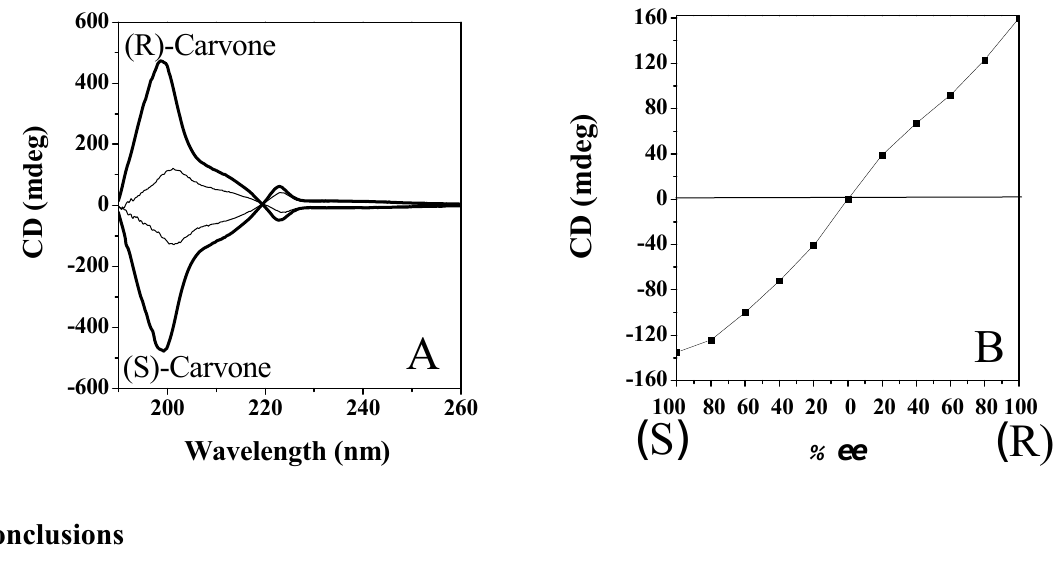
Figure 25. (a) CD spectra of s-PS films, obtained by spin-coating, after exposure to vapor of R or S-carvone. The spin-coating process has been conducted from 1 wt% solutions onto quartz surface at the spin-rate of 1,600 rpm, by using different solvents: chloroform (thick line); tetrahydrofuran (thin line). (b) ICD intensity of the Cotton band at 200 nm for s-PS films spin-coated from a chloroform solution, after exposure to carvone with different enantiomeric